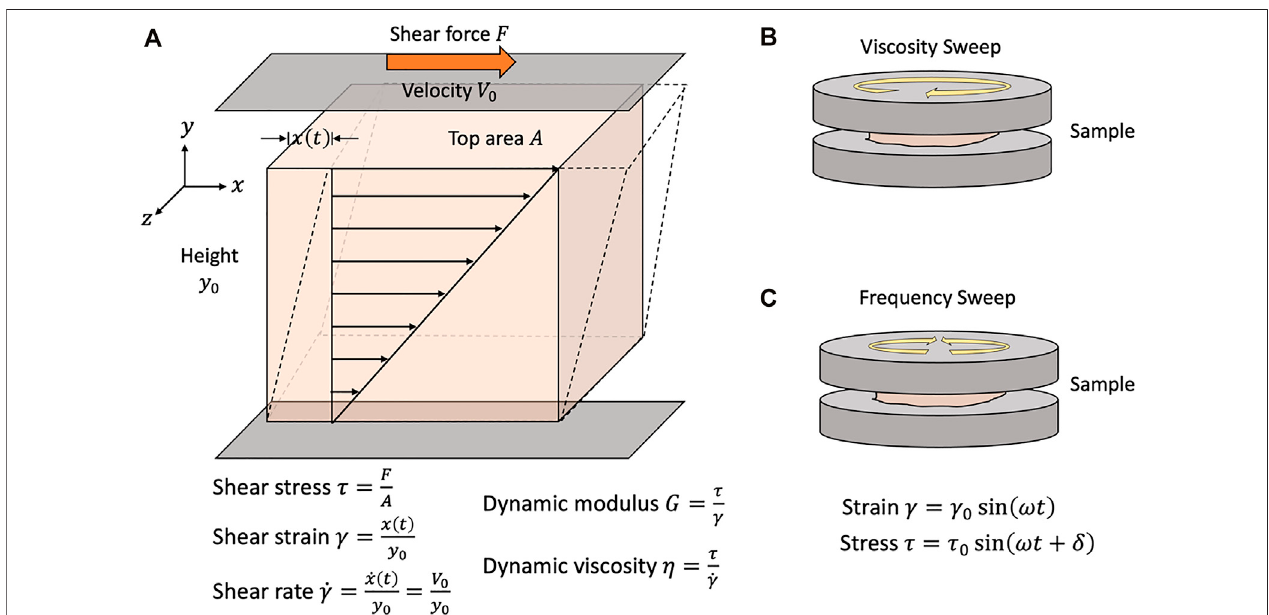
FIGURE 2 | Rheological assessment of biomaterials for bioinks. (A) Principles of rheometric analysis. When a shear force is applied to a material, the material is deformedbyanamountx(t).Theappliedshearstressisafunctionoftheappliedshearforceovertheappliedarea.Theshearstrainisde fi nedasratioofthemagnitudeof this deformation to height of the unit volume. The shear strain rate (or simply shear rate) is time-derivative of the shear strain. Sample material is placed in between two parallelplates, one ofwhich rotates either (B) unidirectionally or (C) oscillates bidirectionally. Under the no-slip assumption, the sample material is sheared at a rate equivalent to the velocity of the rotating plate V0. The dynamic viscosity of a material is de fi ned as the ratio of the shear stress to the shear rate and is empirically determinedbyrampingtheappliedshearrateandmeasuringtheshearstressofthesample.Thedynamicmodulusofviscoelasticmaterialsiscommonlymeasuredwhile applyingoscillatorystrain.Amaximumstrainof γ 0 isappliedatafrequency ω .Theremaybealag-timebetweentheapplicationofthestrainandthemeasuredstress.The phase shift between the stress and strain is given by δ . Viscoelastic materials with predominantly liquid-like characteristics will have a large phase shift, while predominantly solid-like materials will have a smaller phase shift.